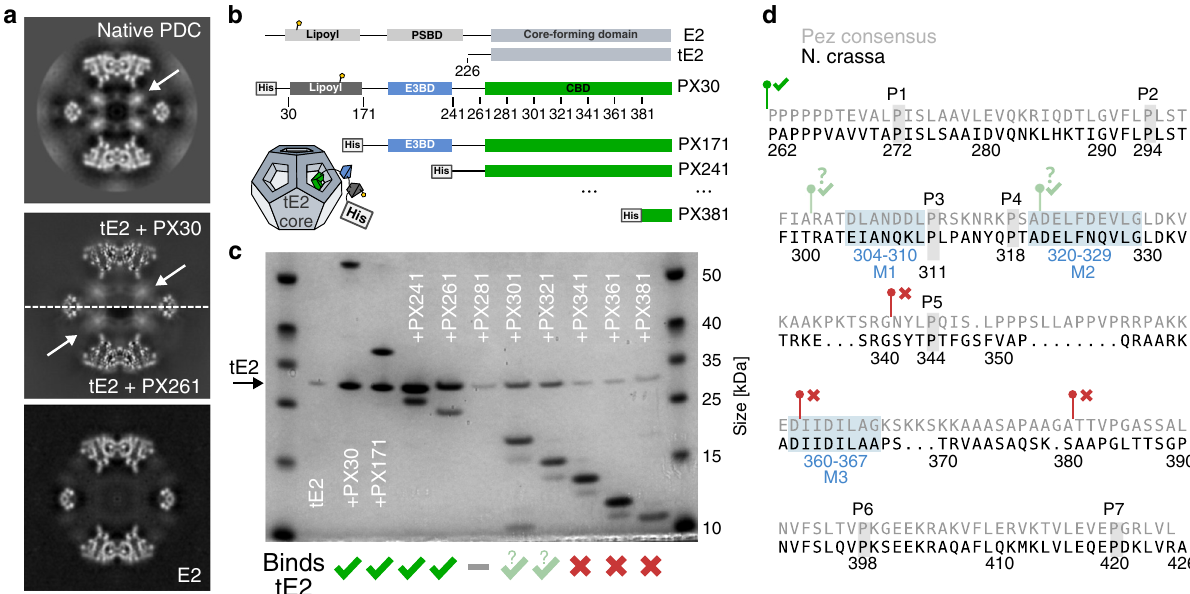
Fig. 3 N. crassa PX is a monomer that oligomerizes upon binding to the PDC core. a Comparison of over-symmetrized interior densities. The native PDC (top) was the only dataset wherein a tetrahedral arrangement of interior densities could be classi fi ed con fi dently. It is however clear that both a reconstituted tE2 + PX30, as well as a co-expressed tE2 + PX261 subcomplex (middle) display similar interior density signatures under icosahedral (over-) symmetrization. The E2 core alone (bottom) does not show this signature. b Schematic of recombinantly co-expressed tE2 and PX constructs used for binding assays. PX<N> indicates truncation of residues 1 – N. c SDS – PAGE showing co-puri fi cation of E2 core assemblies by His-tag af fi nity of PX constructs, illustrating a disproportionate decrease in bound E2 upon truncation past residue 280. PX281 exhibited a complete loss of expression or rapid degradation. Further truncation restored PX expression, but at reduced af fi nity or increased ratio. Binding was completely abolished (comparable to lone tE2, lane 2) following N-terminal truncation past residue 340. d PX CBD sequence from N. crassa aligned to the the Pezizomycotina (Pez) consensus sequence. The seven conserved prolines are indicated, as well as the three conserved H2 E2 -complementary motifs M1 – 3, found in Pez. Notably for N. crassa , M1 does not agree well with the consensus motif (cf. Supplementary Fig. 7). Green and red markers indicate the starting positions and binding of PX